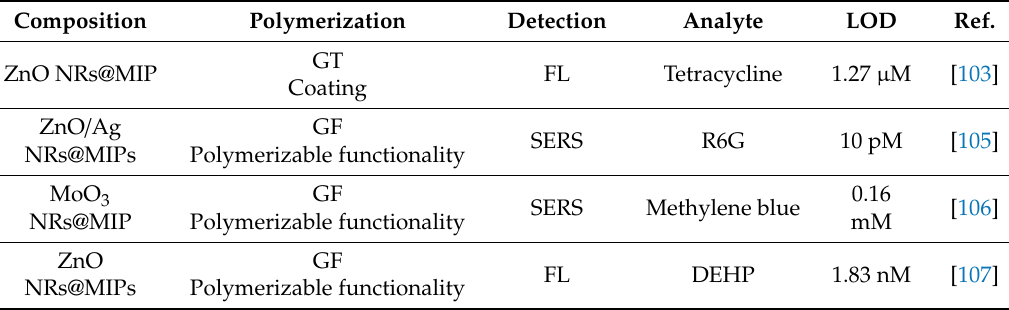
Table 4. Optical sensors based on core-shell MIPs with a metal-oxide core.